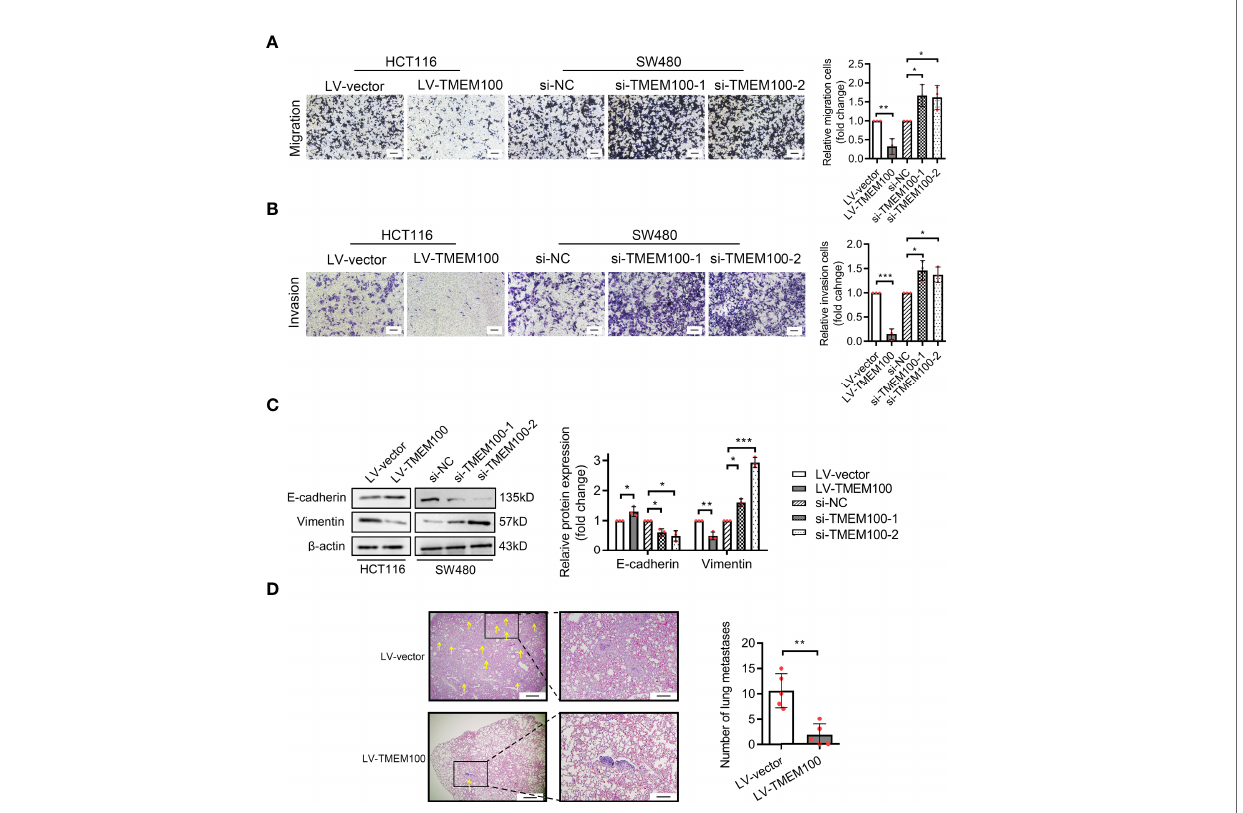
FIGURE 4 | TMEM100 restrains the migration and invasion capacities of CRC cells. (A, B) Transwell assays were performed to evaluate the capacities of migration and invasion in indicated cells. Scale bar = 100 m m. Two-sided t-test. (C) Western blotting analysis of E-cadherin and Vimentin expression in indicated cells. b -actin was used as a reference control. Two-sided t-test. (D) The representative pictures of the metastatic neoplasm in the lung of the mice metastasis model (n=5/group). The section which presents the largest number of CRC cells colonized foci was selected, and the yellow arrow represents the foci of which diameter was a minimum of 1.5 m m. Bar in the left picture represents 5 m m, and bar in the right picture represents 1.43 m m. Two-sided t-test. Data are presented as the mean ± SD. * p <0.05, ** p <0.01, *** p